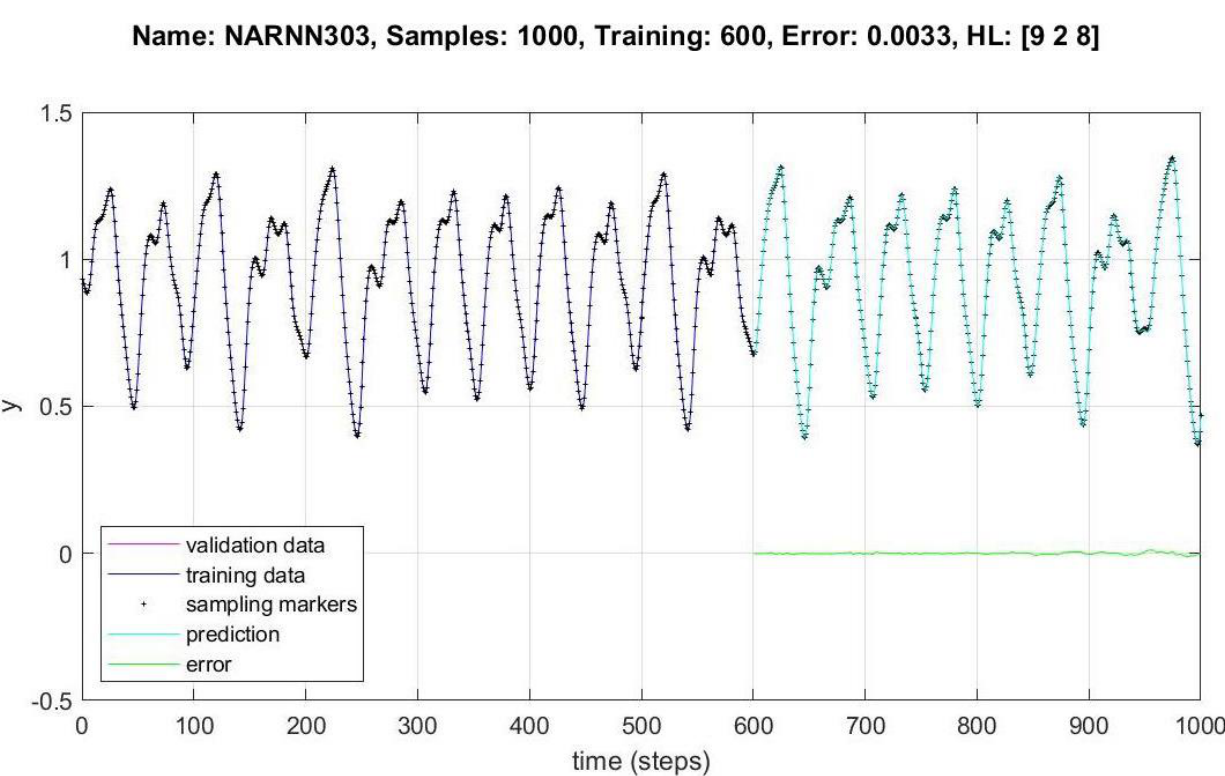
Figure 13. Performance of NARNN303 for 1000 samples